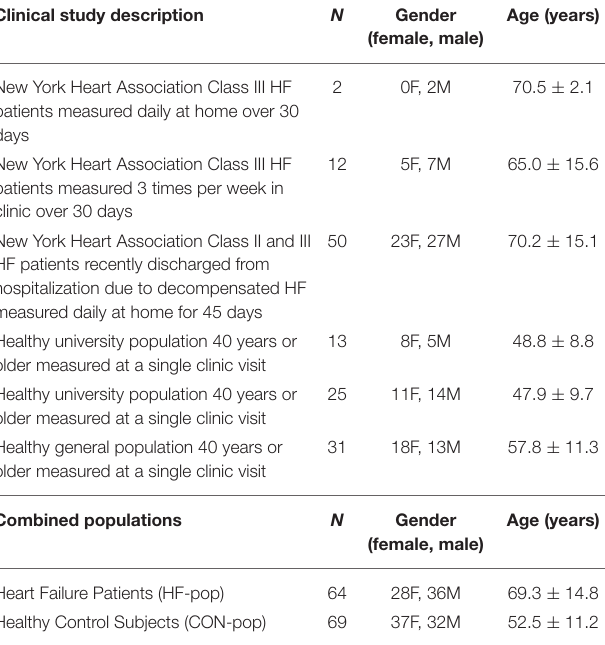
TABLE 2 | Clinical studies enrolling HF patients and healthy control